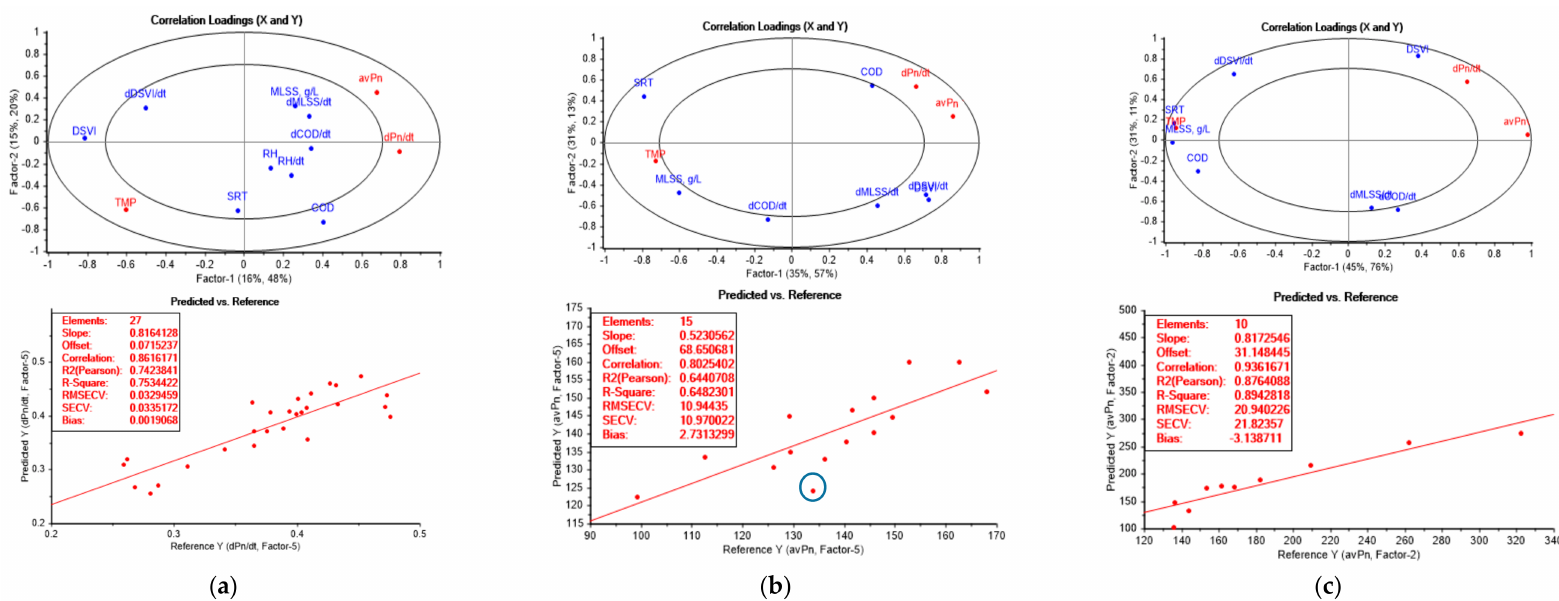
Figure 7. Results of PLSs of the data from all the periods of the filtration performance monitoring, including SRT: ( a ) period A; ( b ) period B; ( c ) period